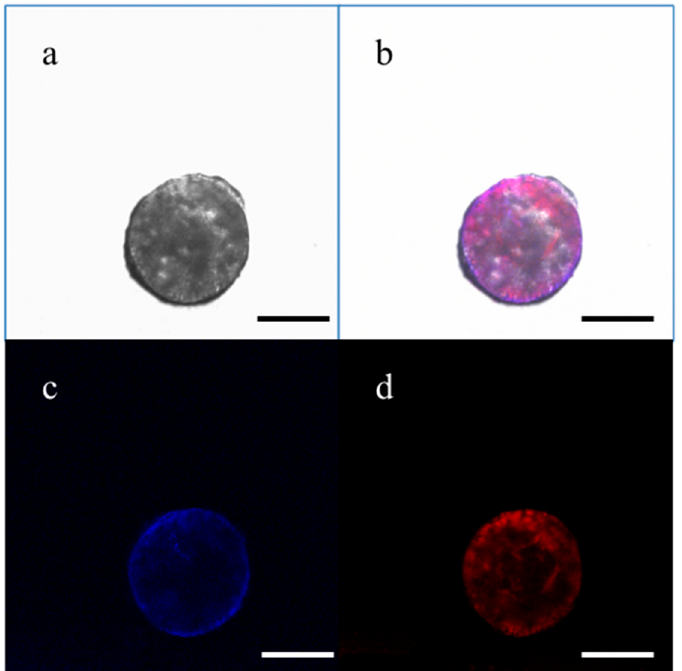
Figure 4. CLSM images of alginate coated with chitosan NPs-encapsulated microcapsule. ( a ) Brightfield, ( b ) Overlaid representation of all the components, ( c ) Emission of Trypan Blue(blue) loaded in chitosan layer and ( d ) Rhodamine B(red) loaded in alginate NPs. Scale bar = 50 µm.